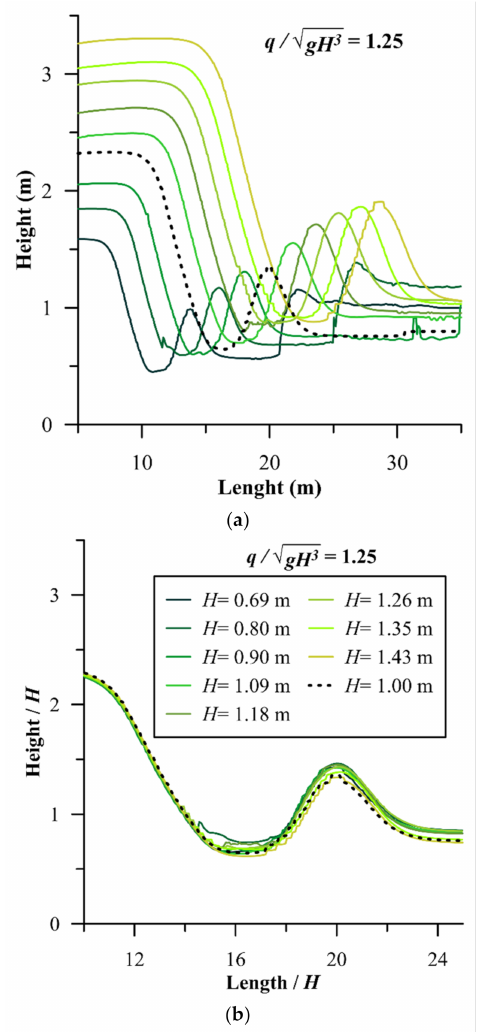
Figure 12. Similarity of wave profiles for ramps of different height; ( a ) natural dimension water surface profiles, ( b ) scaled (dimensionless) water surface